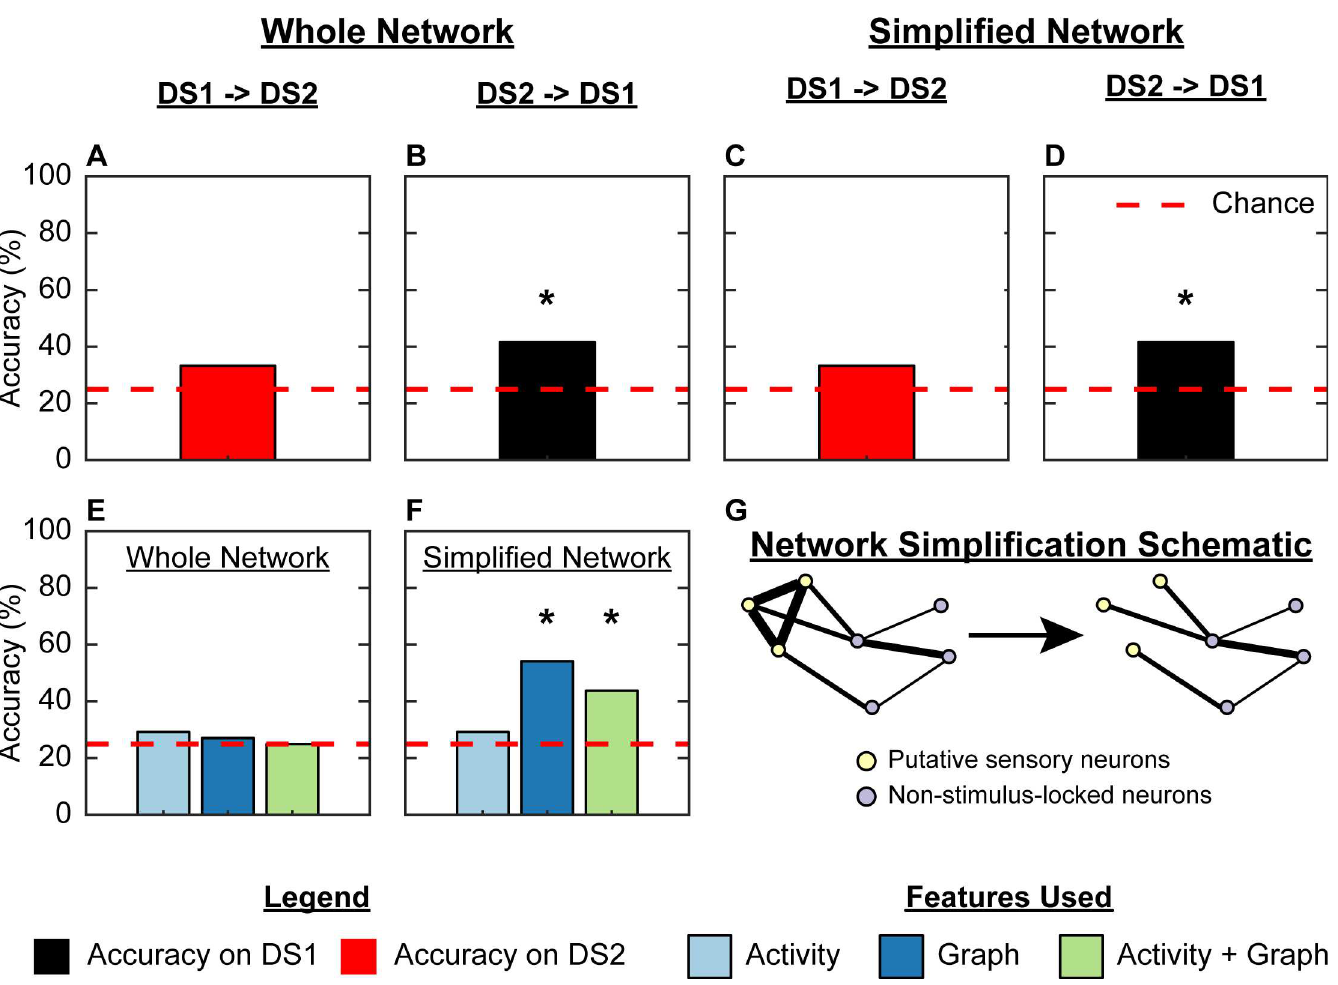
Fig 7. The Simplified Network made by removing trivial interactions between putative sensory neurons improves robustness of the logistic regression classifier, and shows that Graph features alone are capable of discriminating stimulus identity. Graph features from the Whole Network allowed above-chance accuracy when training on Data Set 2 (DS2) and testing on Data Set 1 (DS1; B, � p-value = 0.04), but not vice-versa (A); the same was true of Graph features from the Simplified Net- work, which produced the same accuracies as the Whole Network (C,D, � p-value = 0.04). Moreover, Graph features from the Simplified Network led to above-chance classification accuracy on the combined data set of 48 worms (E,F, � p-value = 0.01), while Activity features could not be used to exceed chance-accuracy. The process of network simplification is depicted in panel G via a cartoon, where we removed the (trivially) strong edges between neurons correlated to stimulus onset (i.e., “putative sensory neurons”, yellow circles). No features were standardized. The dashed red line refers to chance accuracy of 25%. Statistical significance was assessed using a permutation test with n = 100 permutations. N = 24 worms for Data Set 1 (all worms except those exposed to diacetyl), 24 worms for Data Set 2.